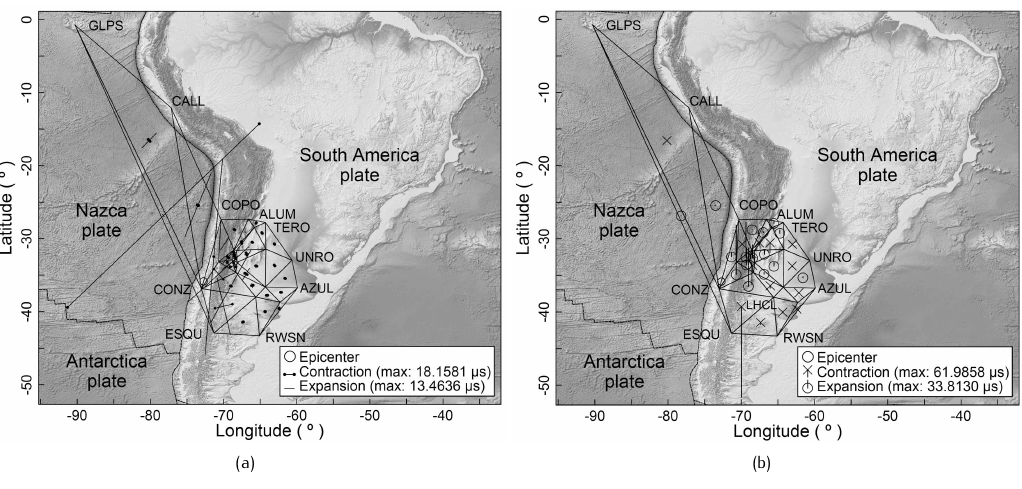
GCGT is in the North-American plate and the points MANA, ETCG, IGN1 and DAVI are in the Caribbean